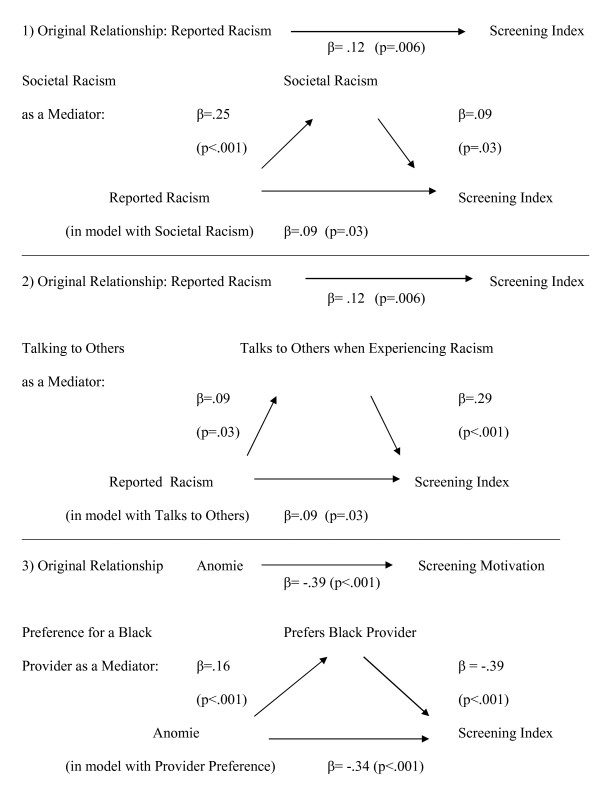
Results of Mediational Analyses Testing Possible Pathways Between Perceived (Reported) Racism and Breast Cancer Screening Motivation. Figure 2 depicts three different mediational analyses, testing pathways from figure 1. In analysis 1, the effect of reported racism on screening motivation is shown to be partially mediated by views on societal racism. In analysis 2, reported racism is partially mediated by the strategy of talking to others when experiencing unfair treatment. In analysis 3, the effect of anomie on screening motivation is partially mediated by preference for a Black physician.